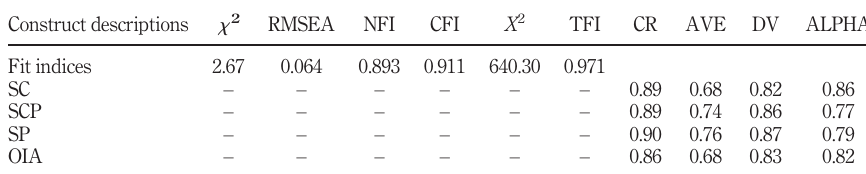
Table 2. Con fi rmatory factor analysis